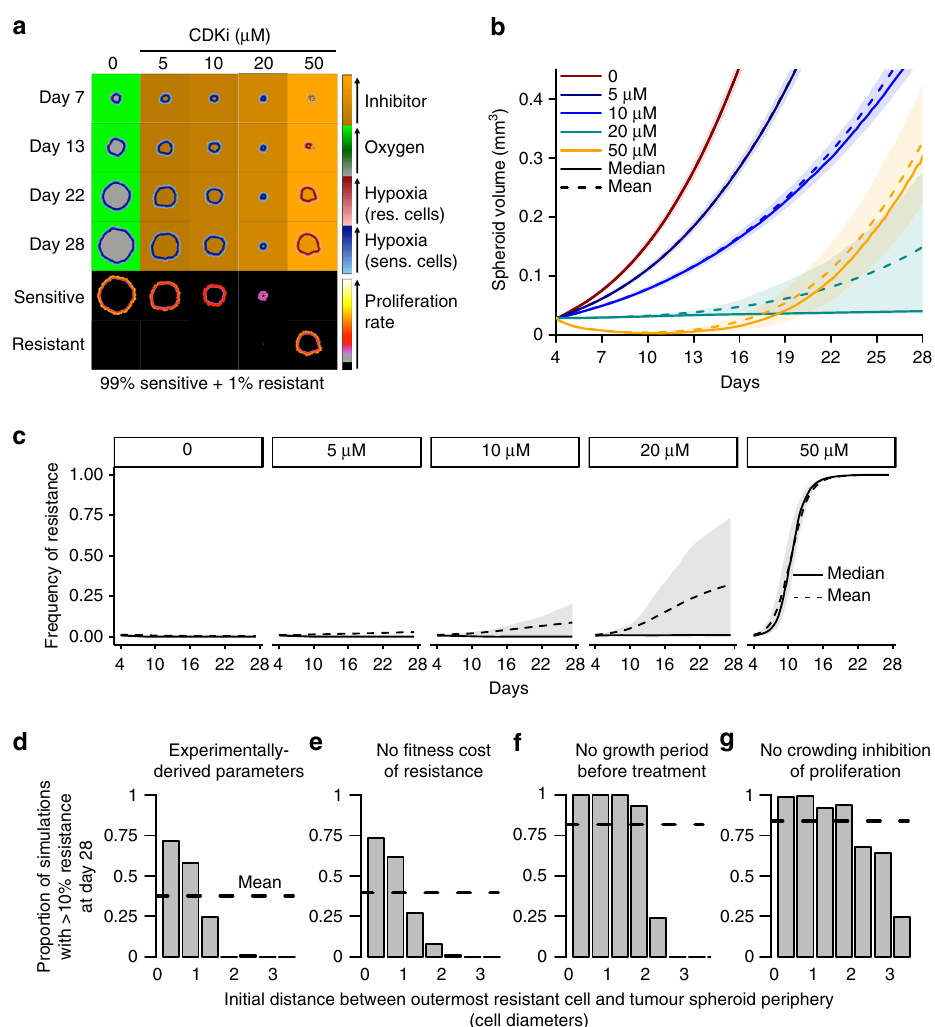
Fig. 5 Spatial structure is a critical determinant of AT ef fi ciency. a Time series of tumour spheroid cross-sections in a spatial computational model. In the upper four rows, cells are coloured according to their type (blue = sensitive, red = resistant) and shaded by local oxygen concentration (darker = more hypoxic); the medium surrounding the tumour spheroid and the necrotic core are coloured according to CDKi concentration (pale orange = high, dark orange = low) or, in the absence of CDKi, are coloured according to oxygen concentration (pale green = high, grey = low). In the lower two rows, cells are coloured according to their proliferation rate (grey = zero, red = low, yellow = high). Typical outcomes were chosen as those in which the fi nal frequency of resistance most closely matched the median. See text and Supplementary Methods for parameter values and assumptions. b Tumour spheroid growth curves for different treatment regimens in the computational model. Medians (solid curves), means (dashed curves) and interquartile ranges (shaded) are shown for 1,000 stochastic simulations. c Frequency of resistance over time in the computational model. Medians (solid curves), means (dashed curves) and interquartile ranges (shaded) are shown for 1000 stochastic simulations. d – g Proportion of simulations in which the frequency of resistance exceeded 10% after 24 days of treatment with 20 μ M CDKi, vs. the initial distance between the outermost resistant cell and the tumour spheroid periphery. Results are shown for 1000 stochastic simulations each of the default model ( d ); a model without a fi tness cost of resistance ( e ); a model with no growth period prior to CDKi treatment ( f ); and a model in which cell crowding does not prohibit proliferation ( g